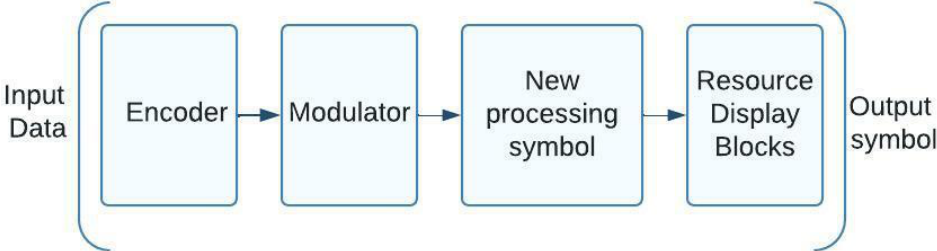
Figure 4. A schematic of a 5G-modulated NOMA transmission